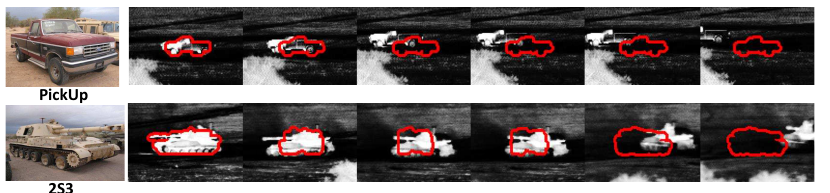
Figure 13. Tracking failure for the pick-up and 2S3 sequences at 1.5